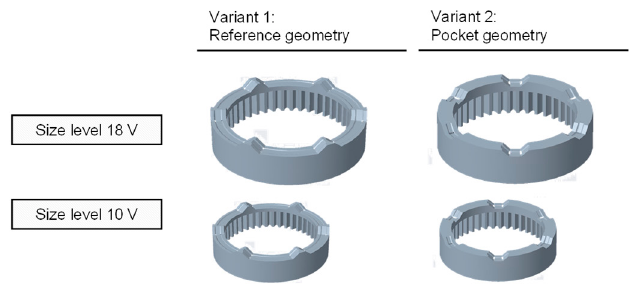
Figure 12. Geometries and size level of the used components of the clutch.